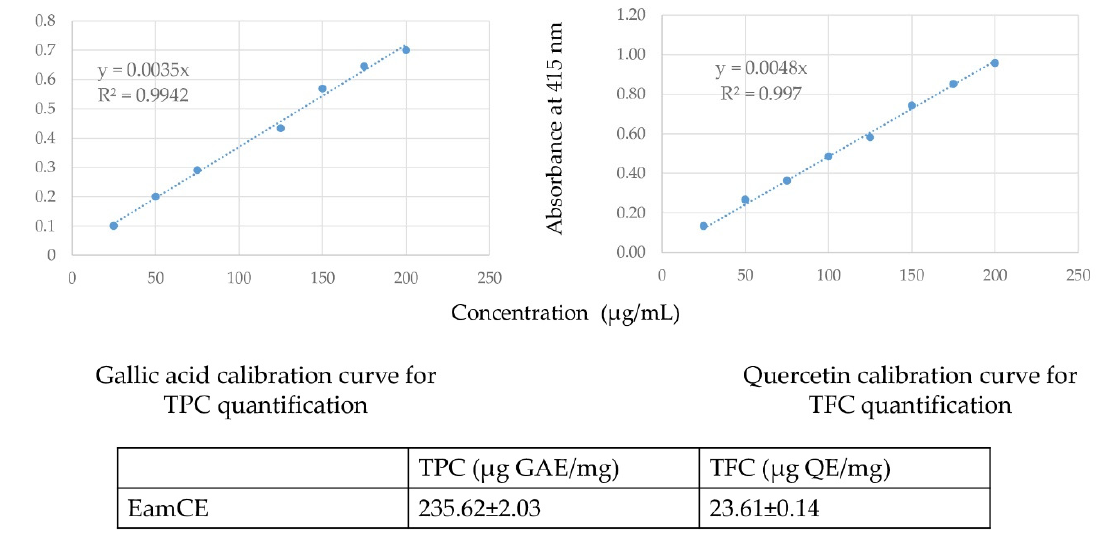
Figure 2. TPC and TFC results. TPC is expressed as µ g gallic acid equivalents/mg of extract ( µ g GAE/mg). TFC is expressed as µ g quercetin equivalents/mg of extract ( µ g QE/mg). Results of in vitro antioxidant and anti-enzymatic tests are reported as the mean values ± SD of three measurements; the IC 50 and A0.5 values were calculated by linear regression analysis and are summarized in Tables 3 and 4, respectively. The EamCE SPF value is demonstrated in Table 5, with reference product SPF values. Table 3. Antioxidant potentials with IC 50 and A0.5 values.